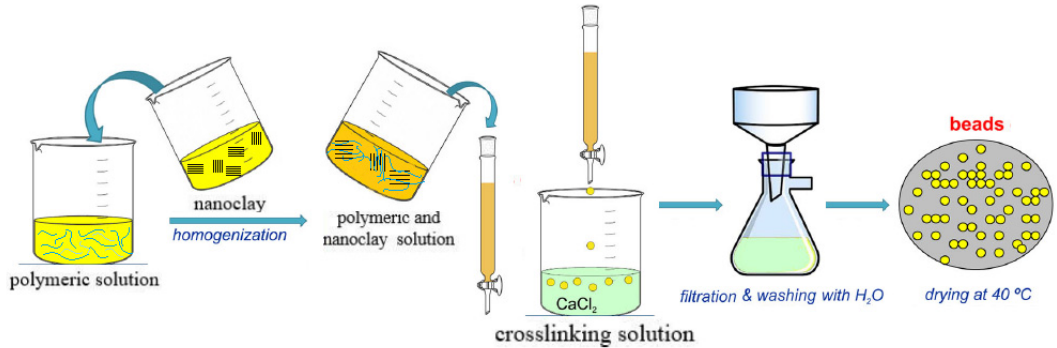
Figure 8. Schematic representation of Ca 2+ alginate/clay nanocomposite hydrogel beads synthesis procedure by [50]. (Adapted with permission from [34]. Copyright 2019, Springer Nature).